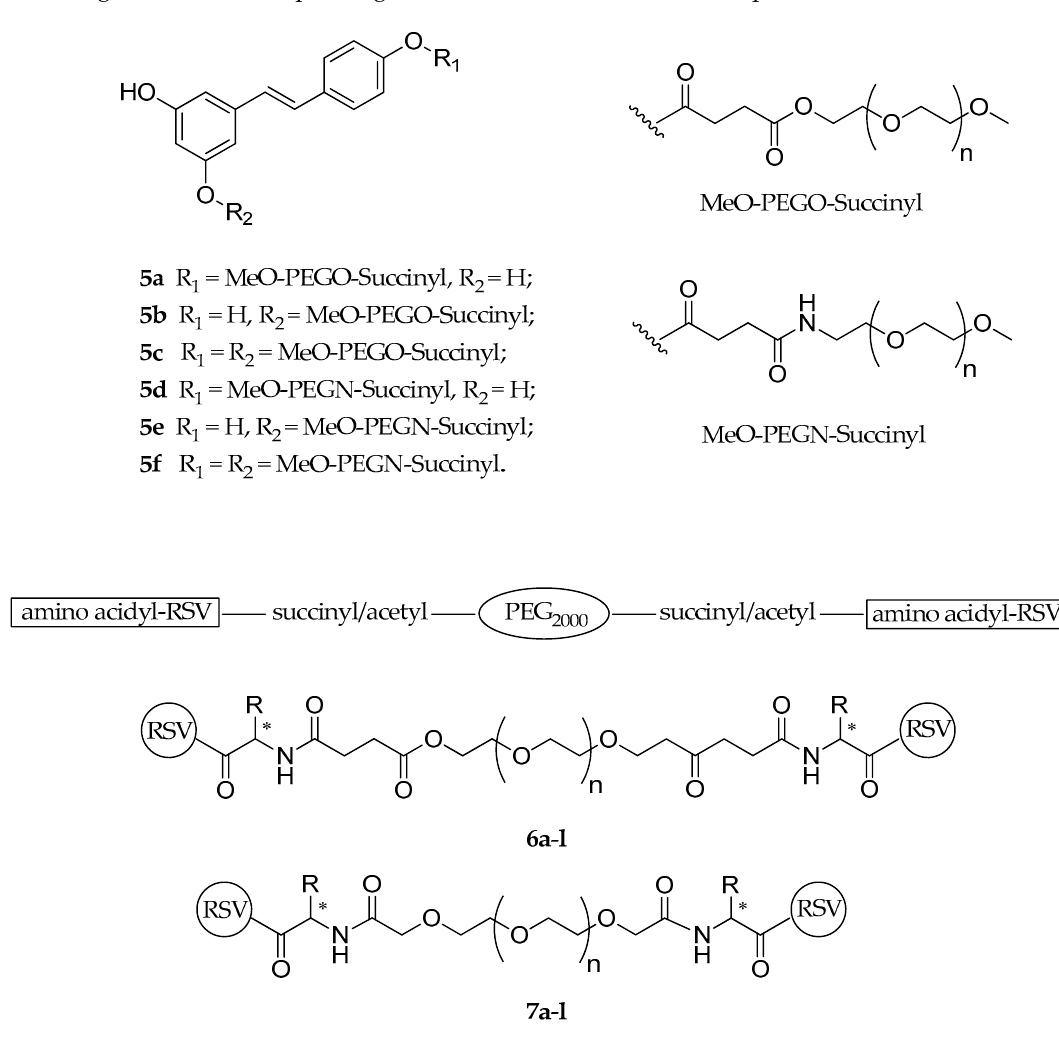
Figure 5. Chemical structures of PEG-resveratrol prodrugs 5a-f , 6a-l , and 7a-l . * = chiral center